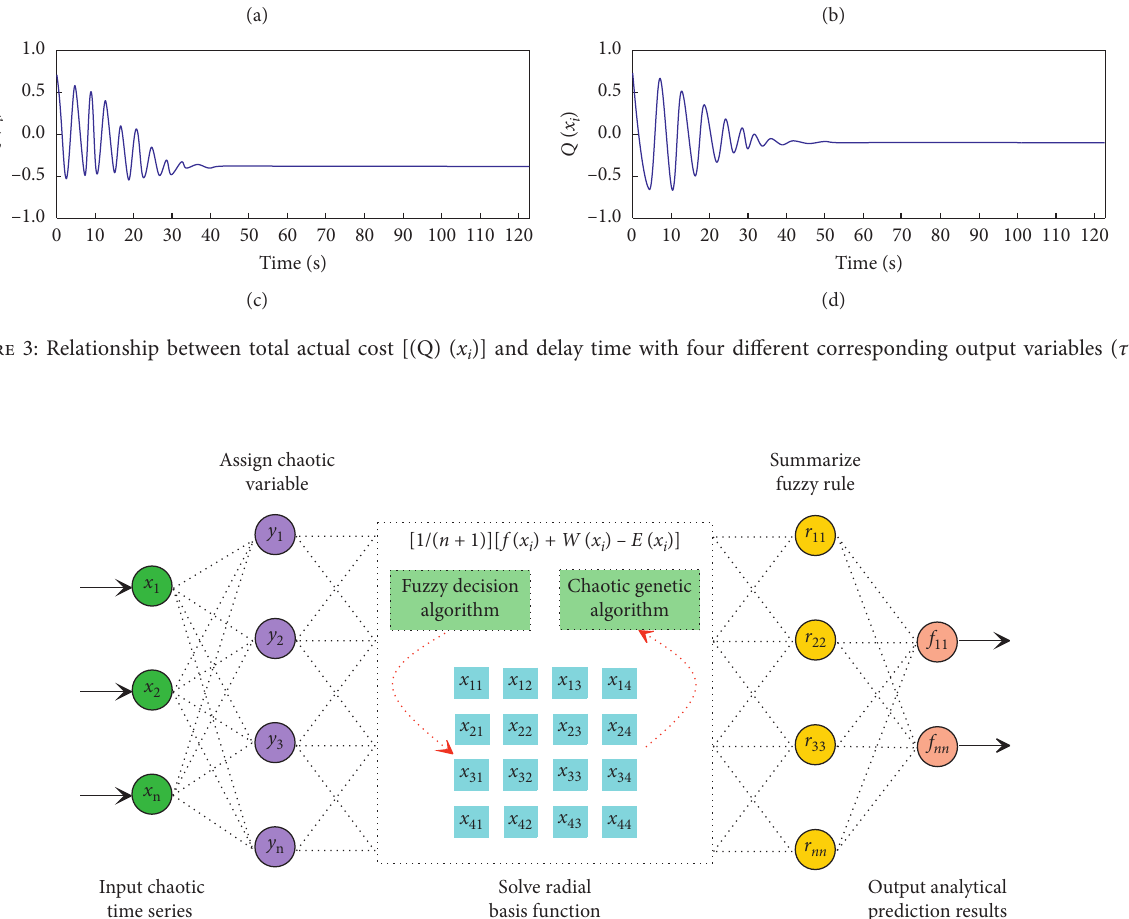
Solve radial basis function